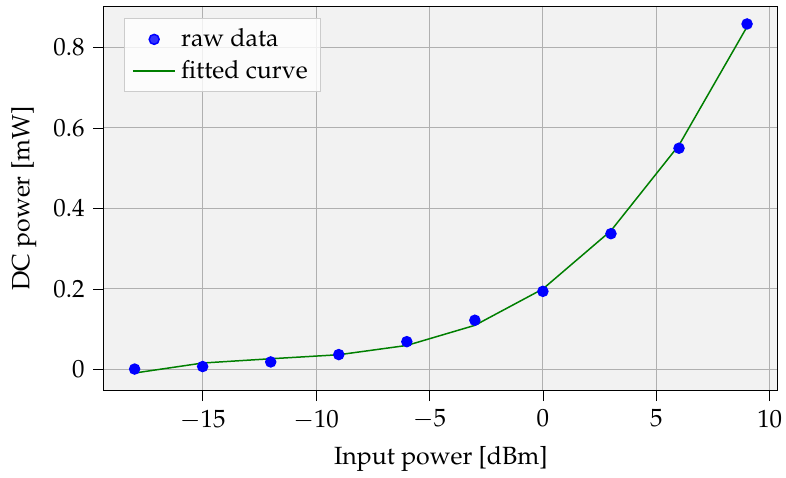
Figure 7. Fitted curve of the raw data of the AEM40940 energy harvester [22]. A third-degree polynomial fitting, as formulated in Equation (13), results in values a = 8.45 × 10 − 5 , b = 3 × 10 − 3 , c = 3.84 × 10 − 2 , and d = 2 × 10 − 1